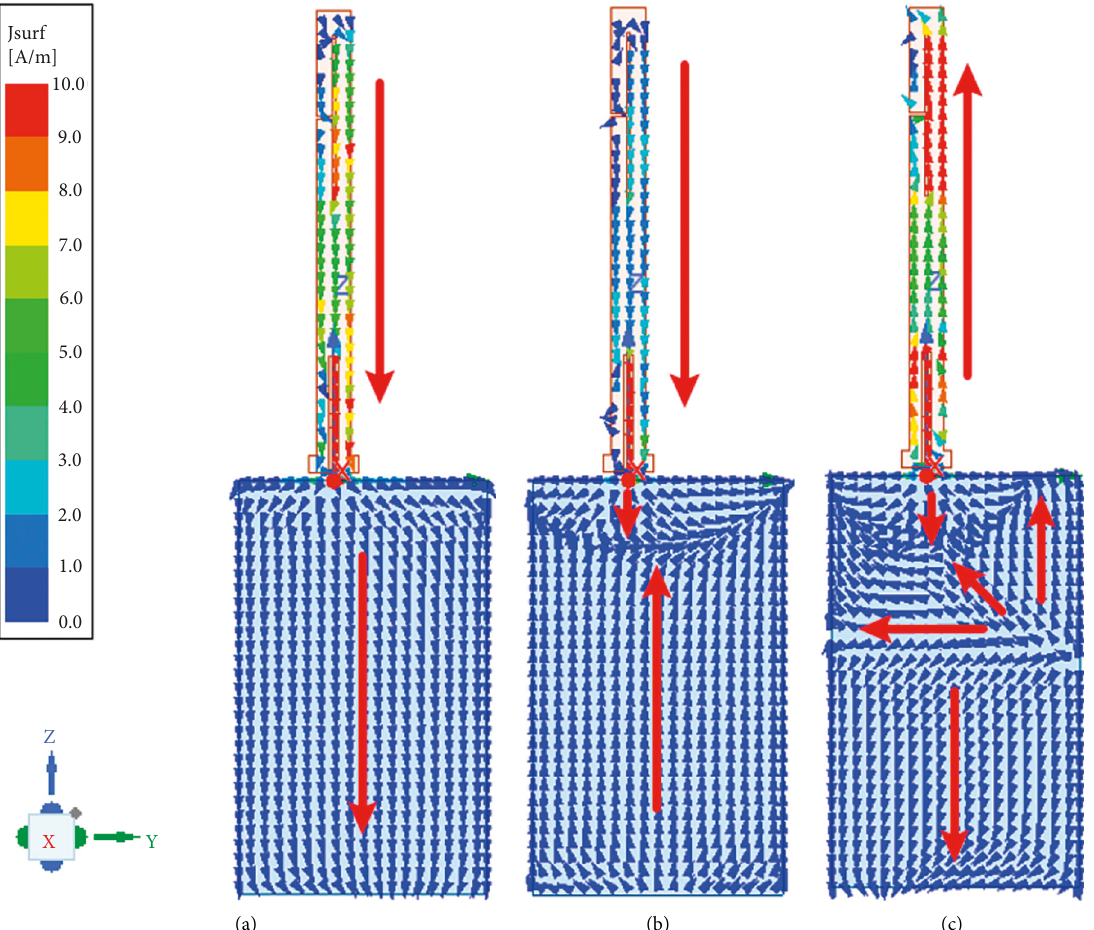
Figure 7: The surface currents (with the feed of 0 deg) of the proposed antenna. (a) 200MHz, (b) 350MHz, and (c)